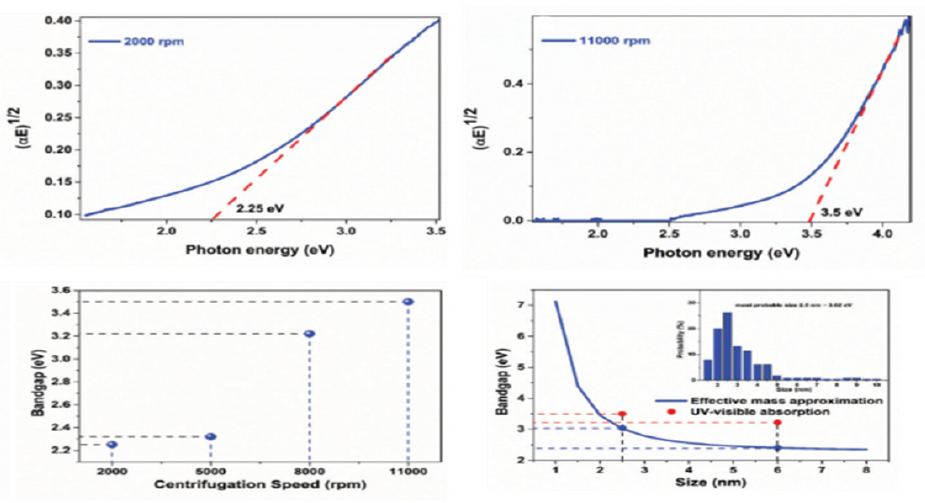
Figure 10. Dependences of ( α h ν ) 1/2 on h ν for SnS 2 QDs, obtained from the absorption spectra in the UV–visible range at 2000 ( left , top ) and 11,000 rpm ( right , top ). Band gap of quantum dots obtained from UV–visible spectra of SnS 2 nanocrystals formed at different centrifugation speeds ( left , bottom ). Dependence of the band gap of the SnS 2 QD on the QD size, obtained in the effective mass approximation (blue line), and the band gap obtained from the spectra in the UV–visible range (red spheres) ( right , bottom ). The inset shows the distribution of QD sizes obtained at a speed of 11,000 rpm and the QD band gap calculated from the effective mass approximation [28].